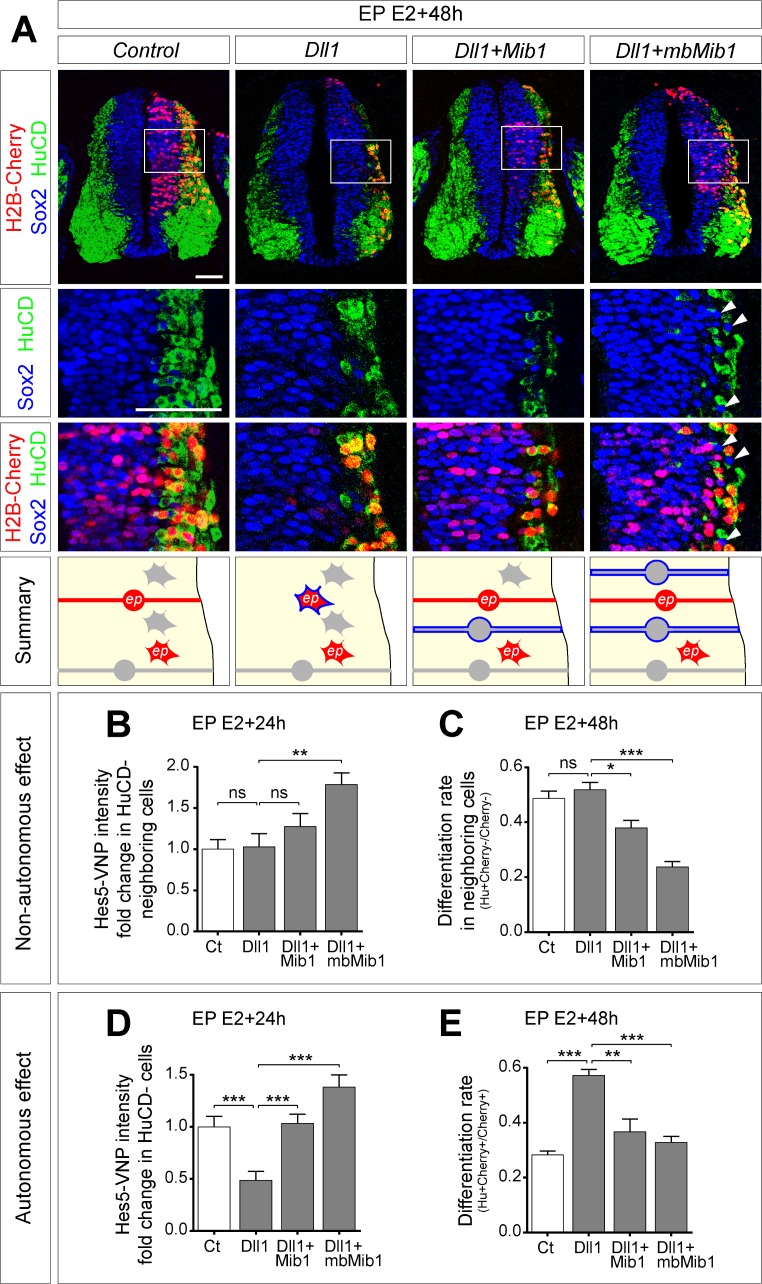
Mib1 blocks the ability of Dll1 to Cis-inhibit Notch signaling.(A) Top: Transverse sections of the NT transfected at E2, with the indicated constructs and harvested at E4. Immunostaining for Sox2 (blue) and HuCD (green) labels progenitors and neurons, respectively. Transfection is reported by H2B-Cherry expression. Arrowheads indicate ectopic Sox2+ progenitors adjacent to HuCD+ transfected neurons. Bottom: Summaries of the effects of Dll1 and Mib1 on neurogenesis. Red and gray cells correspond to electroporated (ep) and non-electroporated cells, respectively. Round and star-shaped cells correspond to progenitors and neurons, respectively. Blue outlines indicate cells changing fate, autonomously or non-autonomously, in each condition. (B, D) Quantification of the Hes5-VNP signal intensity in HuCD− cells either (B) non-transfected (surrounded by at least four transfected cells) or (D) transfected 24 hae with the indicated constructs. Data represent fold change compared to control. (B)
n = 54, 35, 35, 54 cells were analyzed for control, Dll1, Dll1+Mib1, and Dll1+mbMib1, respectively. (D)
n = 58, 59, 59, 66 cells were analyzed for control, Dll1, Dll1+Mib1, and Dll1+mbMib1, respectively. Data were collected from four to six embryos for each experimental group. ns, p > 0.05; **p < 0.01; ***p < 0.001 (Kruskal-Wallis test). (C, E) Quantification of the differentiation rate in (C) non-transfected neighbors (number of non-transfected HuCD+ cells adjacent to a HuCD+ transfected cell on the total number of adjacent cells) or (E) transfected cells (number of HuCD+ cells on total transfected cells) 48 hae with the indicated constructs. Data represent mean + SEM. n = 14 (6 embryos), 10 (8 embryos), 14 (6 embryos), 18 (6 embryos) sections were analyzed for control, Dll1, Dll1+Mib1, and Dll1+mbMib1, respectively. ns, p > 0.05; *p < 0.05; **p < 0.01; ***p < 0.001 (one-way ANOVA). Analyses were performed on the same sections for (B) and (D), and for (C) and (E). Underlying data are provided in S1 Data. Scale bar represents 50 μm. See also S5 Fig. Ct, control; Dll1, Delta-like 1; E, embryonic day; ep, electroporated; hae, hour after electroporation; Hes5, Hairy and Enhancer of Split 5; HuCD, neuron-specific RNA-binding proteins HuC and HuD; H2B-Cherry, Histone 2B fused to Cherry; mbMib1, Mib1 constitutively tethered to the plasma membrane; Mib1, Mindbomb1; ns, nonsignificant; NT, neural tube; Sox2, SRY (sex determining region Y) box 2; VNP, Venus-NLS-PEST.